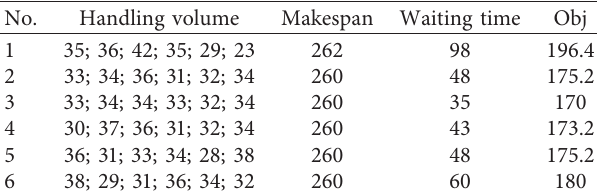
Table 5: The experiment results of different handling volume assignment of yard cranes.